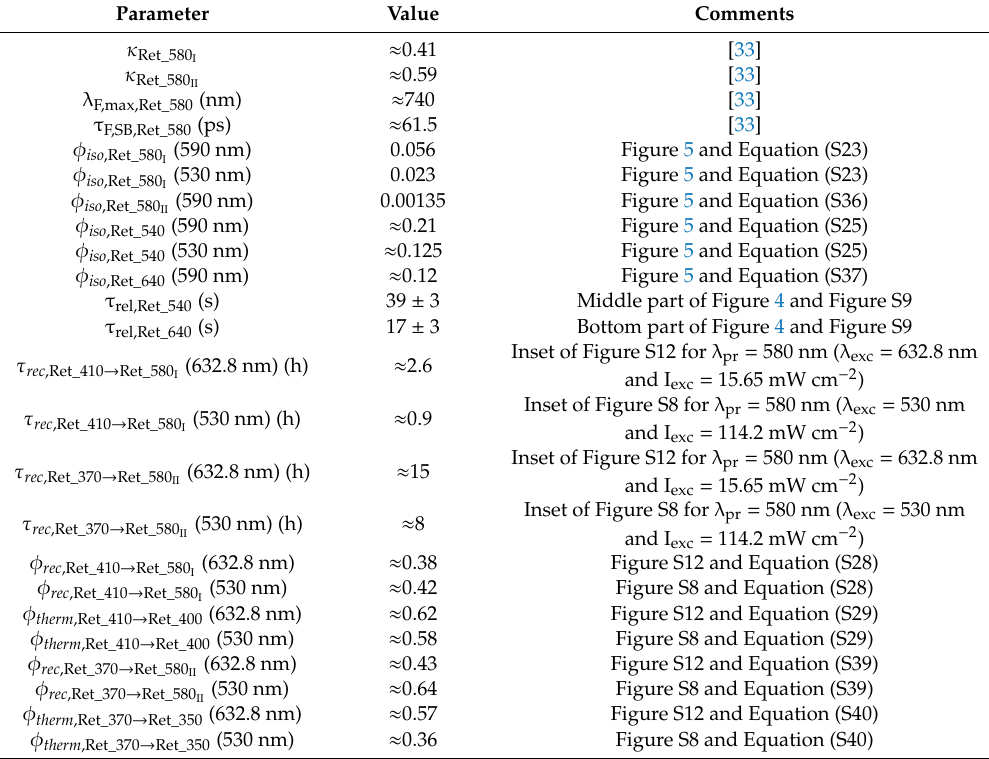
Table 1. Photodynamics parameters of QuasAr1 in pH 8 Tris bu ff er.